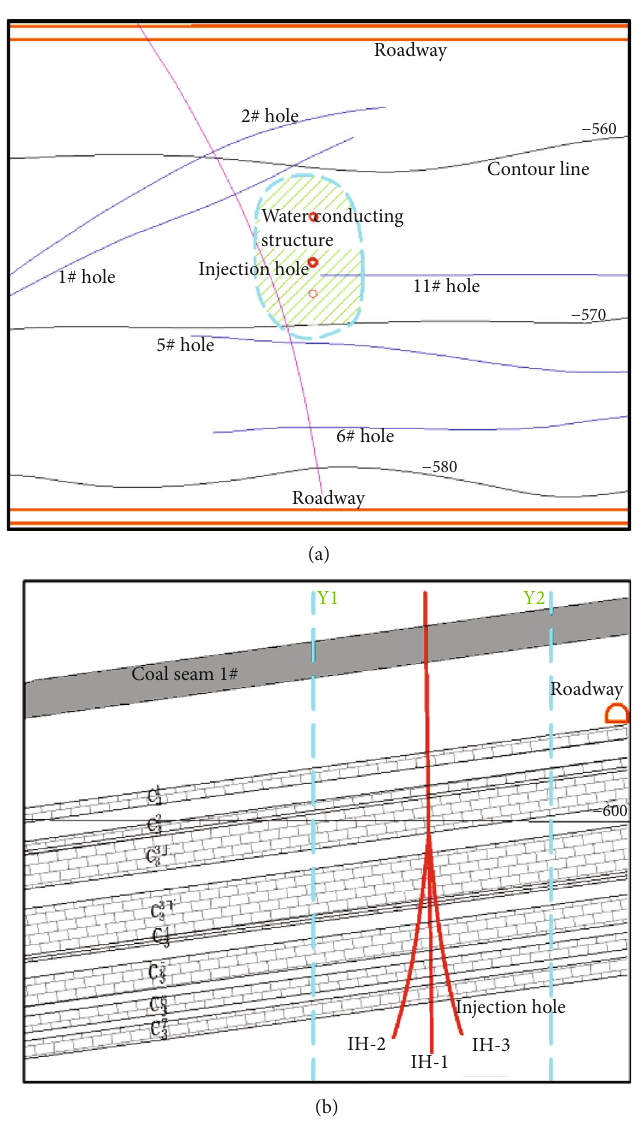
Figure 10: Grout holes in engineering. (a) Grouting plane diagram. (b) Grouting section